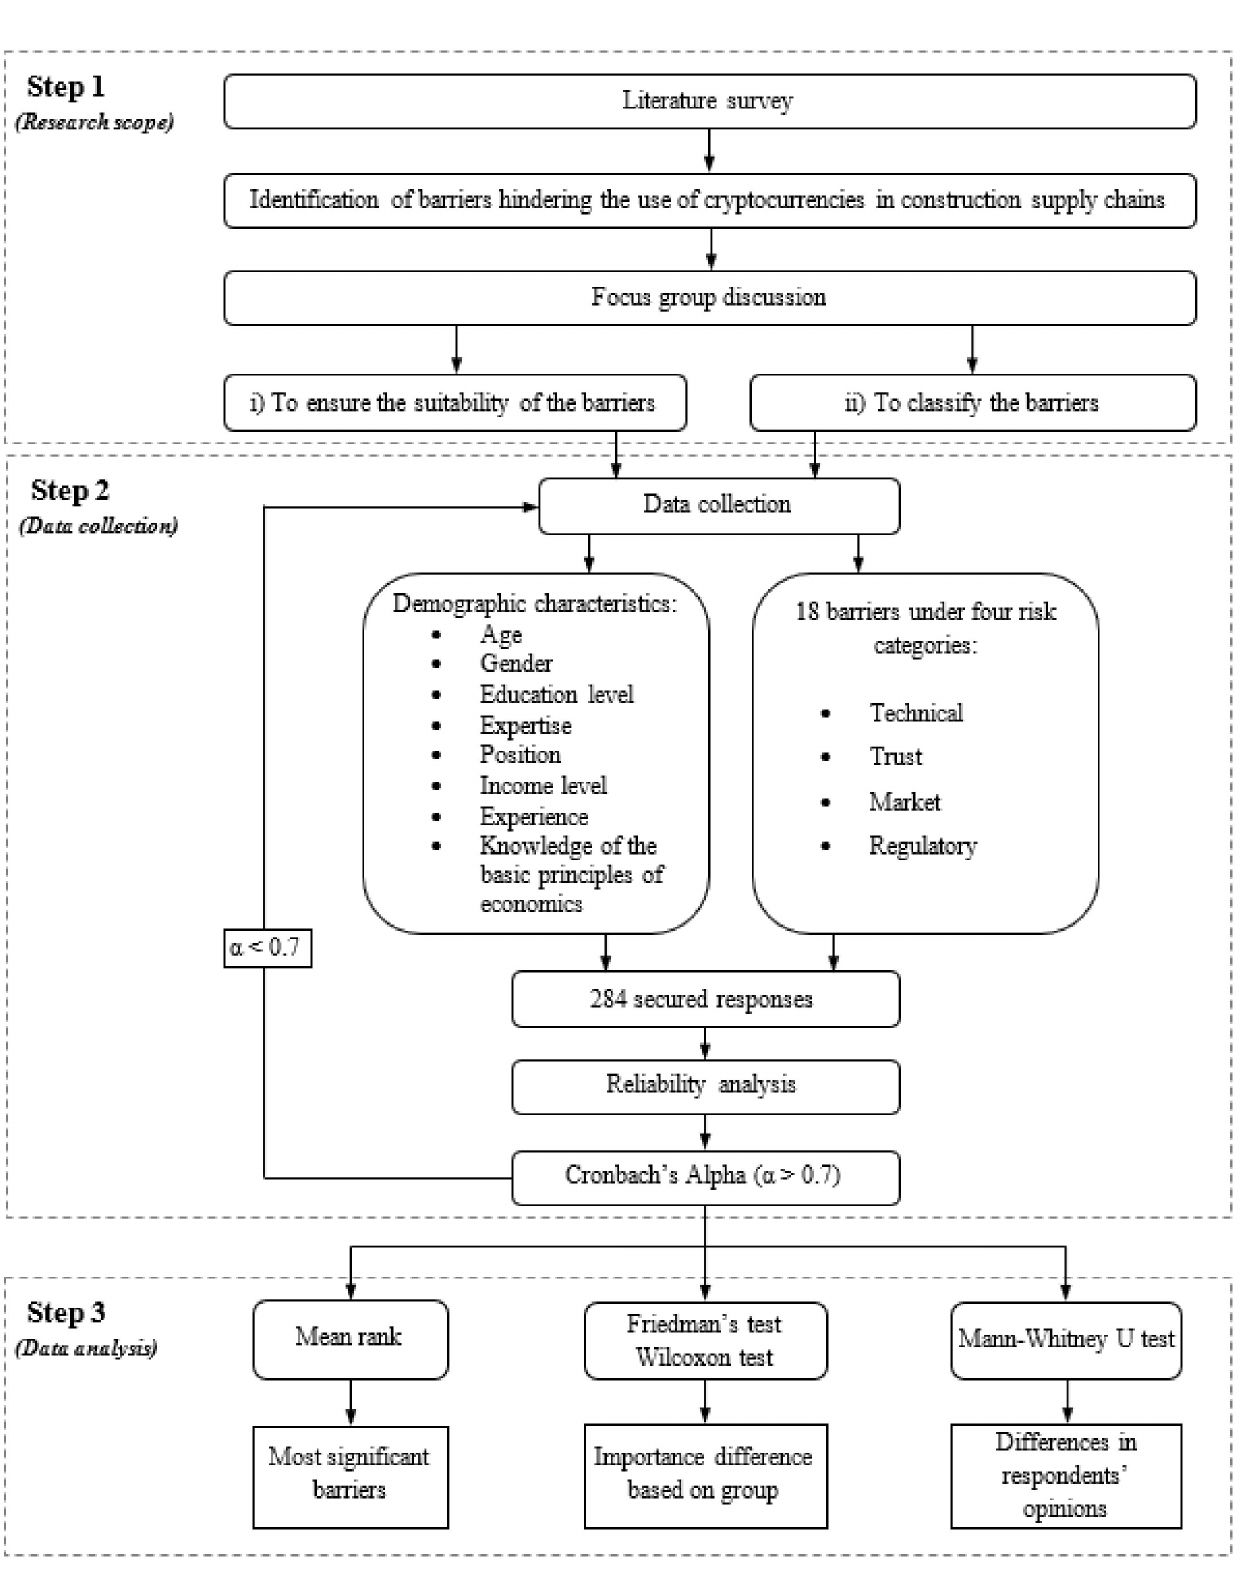
Figure 2. Research